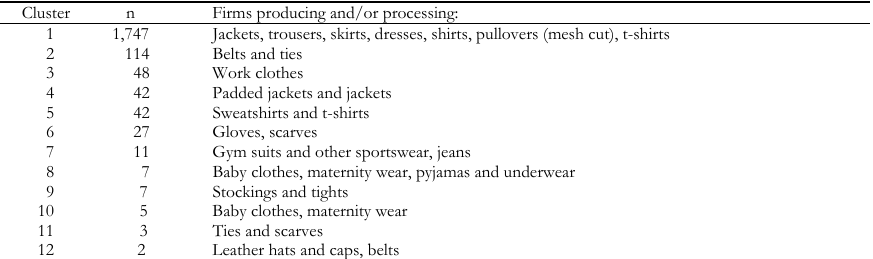
Description of clusters of